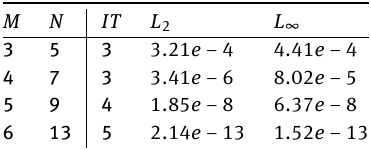
Table 4: The convergence rate of the proposed method to solve example 2.